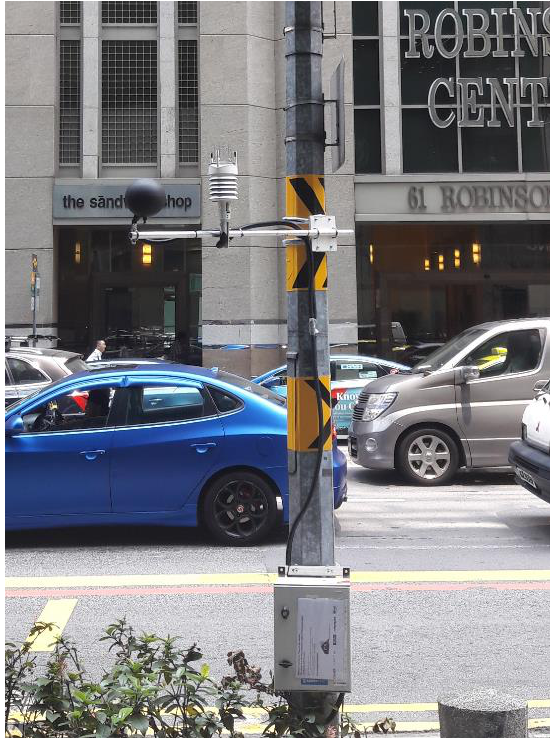
Figure 1. Visual description of the sensors deployed in each site.